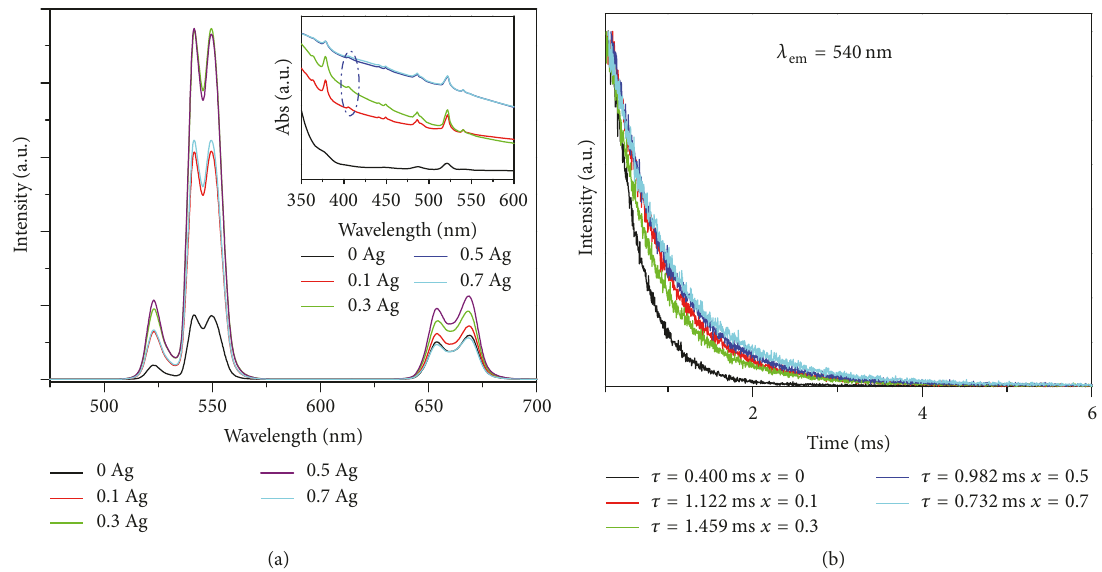
Figure 3: (a) UC luminescence spectra of samples with different Ag concentration under the excitation of 980 nm laser diode: the inset is absorption spectra of samples by modulating the Ag concentration. (b) Room temperature luminescence decay curves of 4 S 3/2 → 4 I 15/2 (Er 3+ ) transition of the 0 Ag, 0.1 Ag, 0.3 Ag, 0.5 Ag, and 0.7 Ag